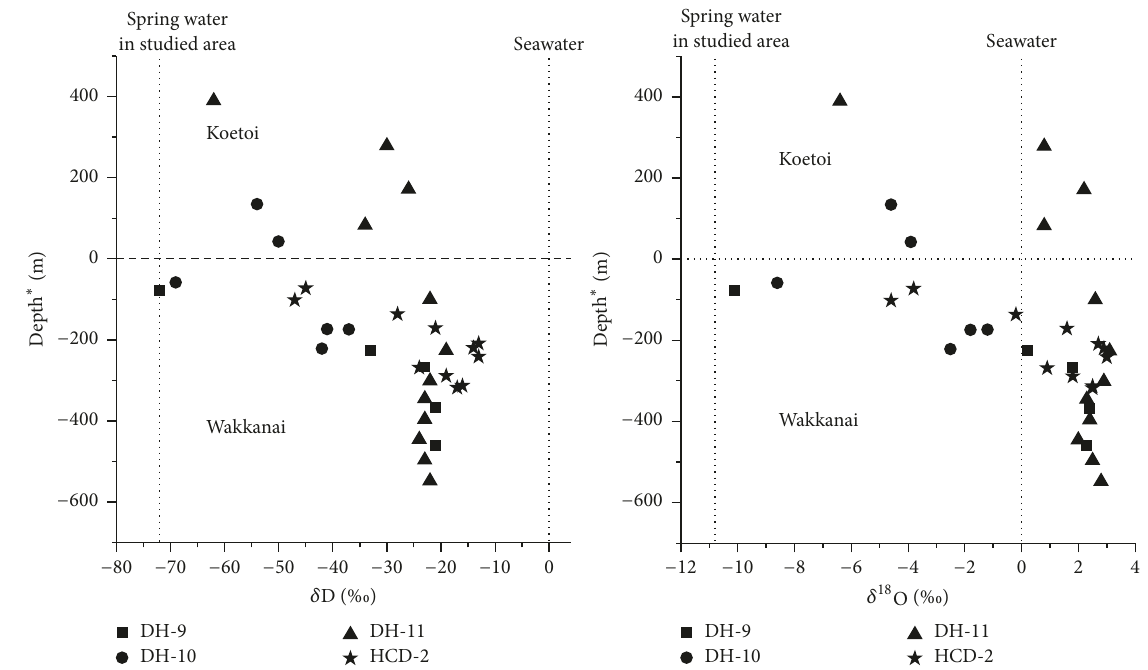
Figure 7: Depth profile of 𝛿 D and 𝛿 18 O concentration in the Koetoi and Wakkanai formations.